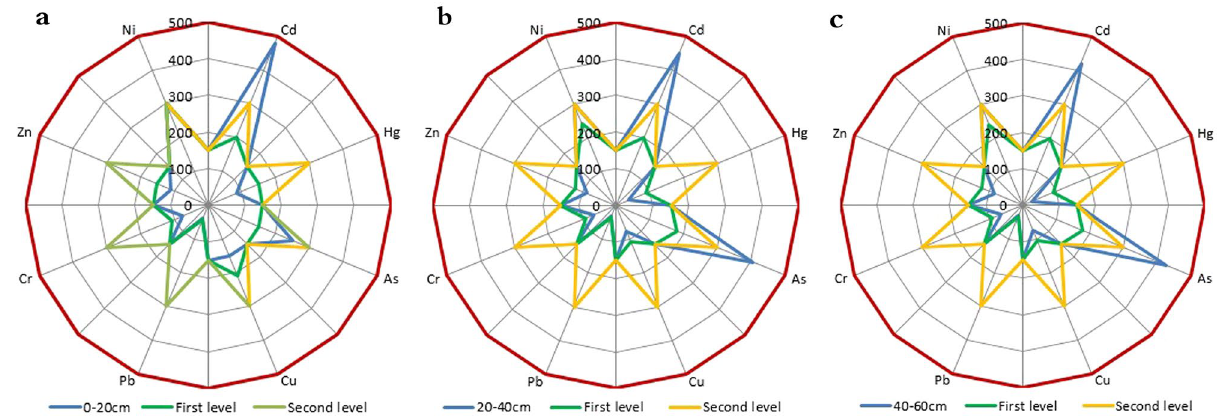
Figure 1. Environmental quality equal intercept transformation radar chart of the soil in the low mountainous area.